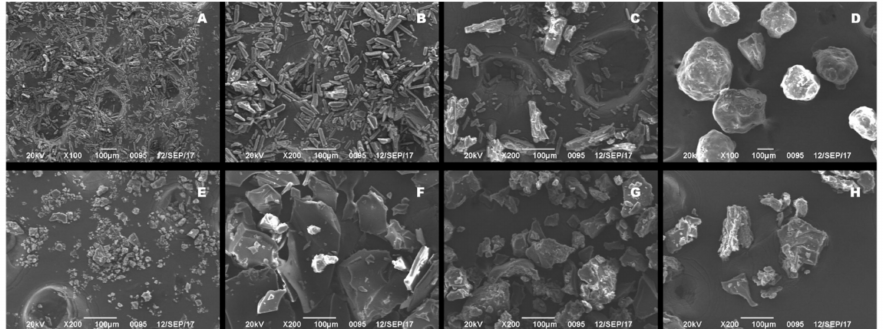
Figure 2. Analysis of scanning electron microscope on crystalline NIT (( A ), 100 × ), crystalline NIT (( B ), 200 × ), NIT PM (( C ), 200 × ), Soluplus ® (( D ), 200 × ), NIT AM (( E ), 200 × ), saSMSD/ NIT NC CP (( F ), 200 × ), saSMSD/ NIT NC FQC (( G ), 200 × ), saSMSD/ NIT C HME (( H ), 200 × ).